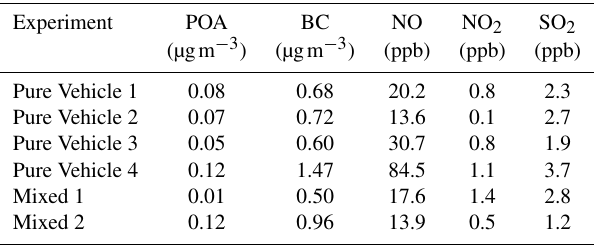
Table 3. GDI-vehicle-emitted species prior to any adjustments or photochemistry